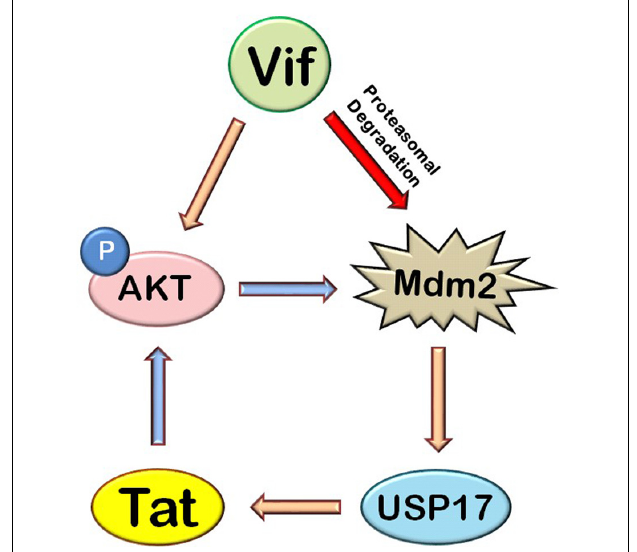
FIGURE 8 | Mechanistic model of HIV-1 Vif–mediated up-regulation of Tat via AKT signaling pathway. HIV-1 Tat induces AKT signaling pathway and increases the phosphorylation of AKT and Mdm2. HIV-1 Vif increases the expression of Tat protein via AKT signaling pathway where Mdm2 acts as the mediator. Mdm2 increases the expression of Tat by inducing an increase in the levels of USP17, which stabilizes the levels of Tat by deubiquitination. HIV-1 Vif also induces proteasomal degradation of Mdm2 (blue arrows: previously known phenomena, golden yellow arrows: novel inductions, red arrows: novel